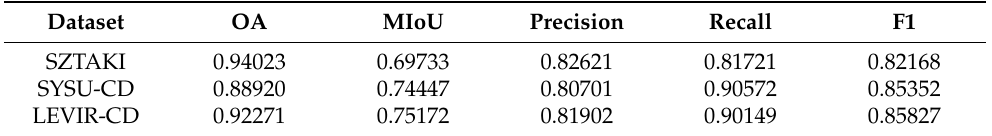
Table 6. The experiment results of channel attention SFA on three standard datasets.